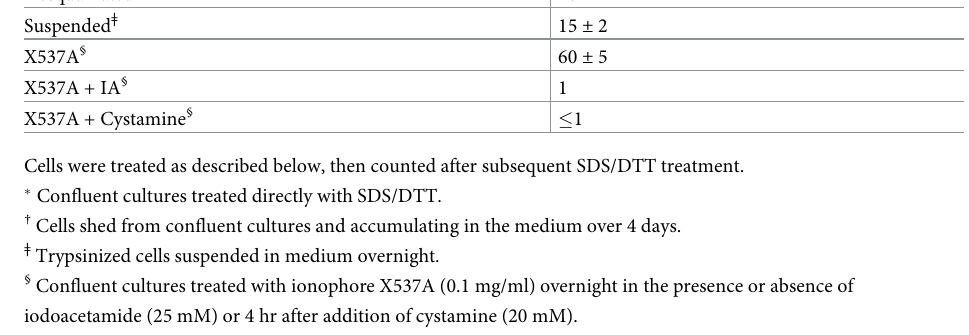
with iodoacetamide or cystamine, which block the active site cysteine of transglutaminase [39, 40] and thereby prevent protein cross-linking (Rice and Green, 1979). Similarly, treating the sturgeon cultures with iodoacetamide or cystamine prevented ionophore induction of enve- lope formation. As seen in S1 Fig in S1 File, ionophore-inducible envelope formation appeared largely independent of cell density, a feature that distinguishes among epithelial cell lines derived from various rat tissues [41, 42]. Finding that the sturgeon cells were capable of cross-linked envelope formation stimulated a search for expression of a TGM1-like gene in them. Sequencing of the 120 chromosome ster- let sturgeon genome has revealed two TGM1-like genes [33], and it was unknown how many TGM1-like genes would be present in the 240 chromosome white sturgeon with four times the diploid chromosome number [30]. Using those exon sequences to interrogate the white stur- geon genomic DNA revealed two homologous genes, although exons 1 and 2 were not retrieved. (Sequences of a Factor XIII-like and a TGM2-like, but no other TGM1-like, genes were identified.) Using RNA isolated from the cultures permitted cloning these two genes to complete the translated sequences (given in S3 Table in S1 File). As seen in Table 2, the white and sterlet A forms had high levels of amino acid sequence identity (98%) as did the B forms (95%), whereas comparison of A and B forms from each species revealed lower degrees of identity (70–77%). Considerably lower degrees of identity (55–62%) were evident in compari- sons of white or sterlet sturgeon Tgm1 A and B forms with those from tilapia, a representative teleost. White refers to white sturgeon. Sequences employed were those indicated by the accession numbers in Table 3.